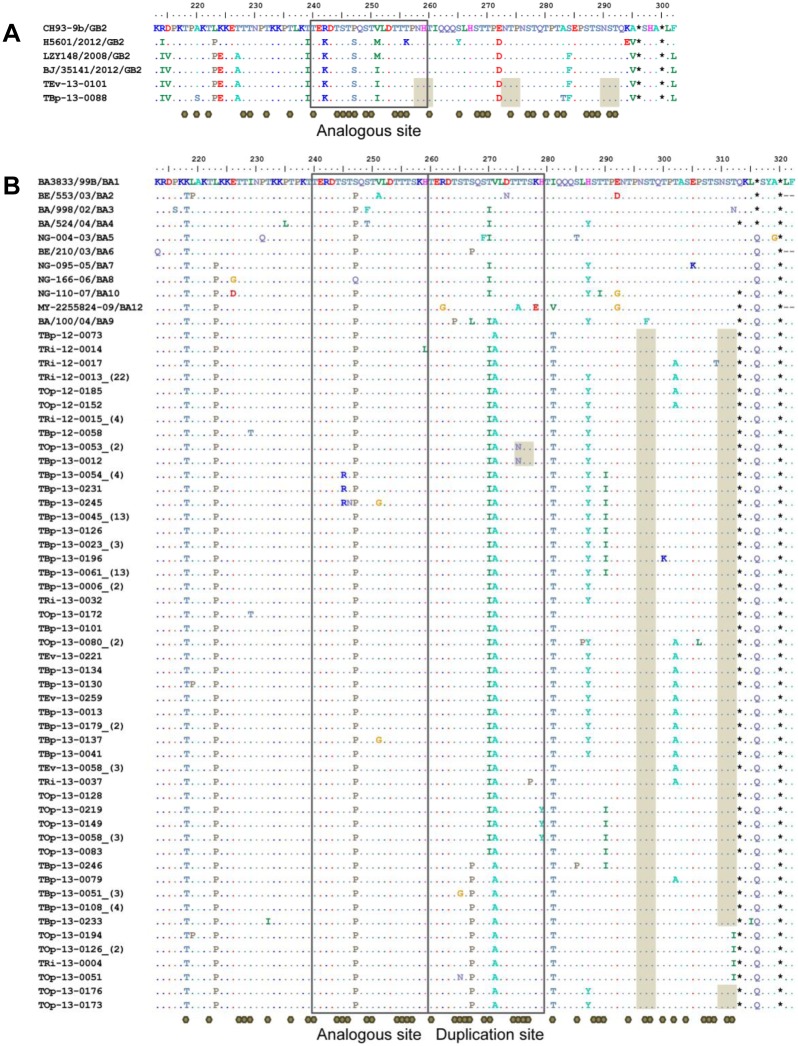
Deduced amino acids of representative HRSV-B G protein in 2012–2013.(A) Two GB2 amino acid sequences corresponding to position 213 to 302 of the 2nd HVR of G protein were aligned with the prototype GB2 strain, CH93-9b (AF065251). (B) Forty-nine representative unique BA9 amino acid sequences corresponding to position 213 to 322 of the 2nd HVR of G protein were aligned with the prototype BA strain, BA3833/99B (AY333362) and the other prototypes of BA branches. Gray shading for predicted N-linked sites, gray octagons for predicted O-linked sites, dots for identical residues, asterisks for stop codon positions, star for positive selection position, and boxes for analogous sites/duplication sites are indicated.